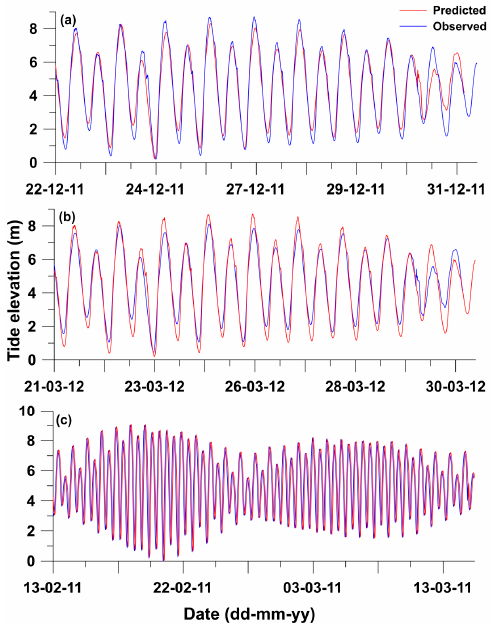
Figure 3. Comparison of observed and predicted tide elevation at three locations of GoK; ( a ) Dahej, ( b ) Surat, and ( c ) Bhavnagar. The location details, along with comparison statistics, are presented in